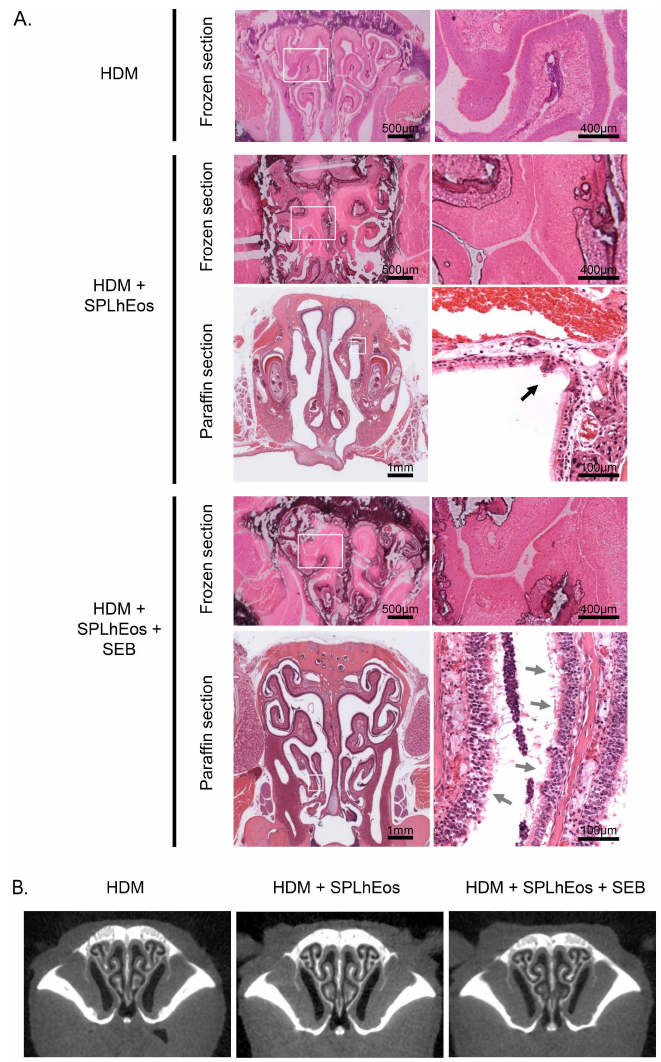
Figure 3. Histological ( A ) and CT ( B ) analyses on the transfer of SPLhEos with house dust mite (HDM). Transfer of HDM alone, HDM with SPLhEos (4 × 10 7 cells), and HDM with SPLhEos (4 × 10 7 cells) plus Staphylococcus aureus enterotoxin B (SEB) were grouped into the adoptive transfer system (two individual experiments with n = 4 or 5 mice per group). Subfigures ( A , B ) indicate histology in H&E-stained frozen and paraffin-embedded sections, and coronal images taken by the CT scan in the paranasal sinus,